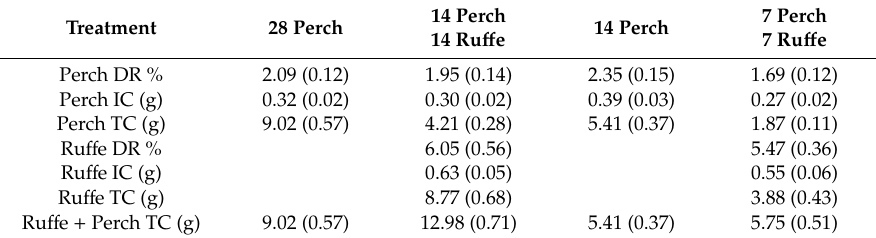
Table 1. Estimates of average daily food consumption by ru ff e and yellow perch during the first (1996) experiment, based on bioenergetics modeling. Daily ration (DR) is reported as percent wet mass and daily individual (IC) and total (TC) consumption (means for each treatment) are reported in grams wet mass per day. Standard errors (SE) are based on four replicates (mesocosms) of each treatment, except 7 Perch and 7 Ru ff e, where n = 3.